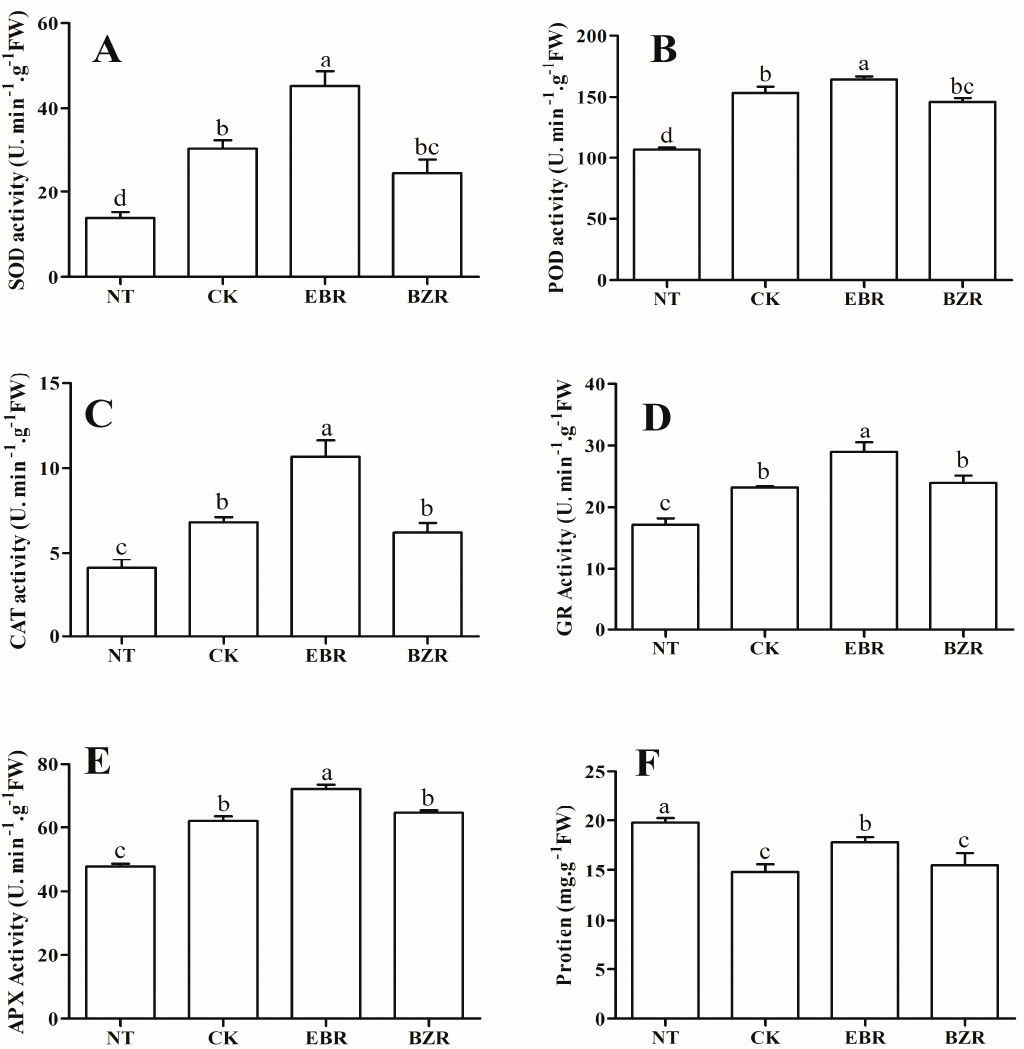
Figure 2. Effect of EBR application and low-temperature stress on antioxidant enzyme activities ( A ) superoxide dismutase (SOD), ( B ) peroxide (POD), ( C ) catalase (CAT), ( D ) glutathione reductase (GR), ( E ) ascorbate peroxide (APX), ( F ) protein) in cucumber seedlings. Different letters indicate significant differences at p < 0.05.